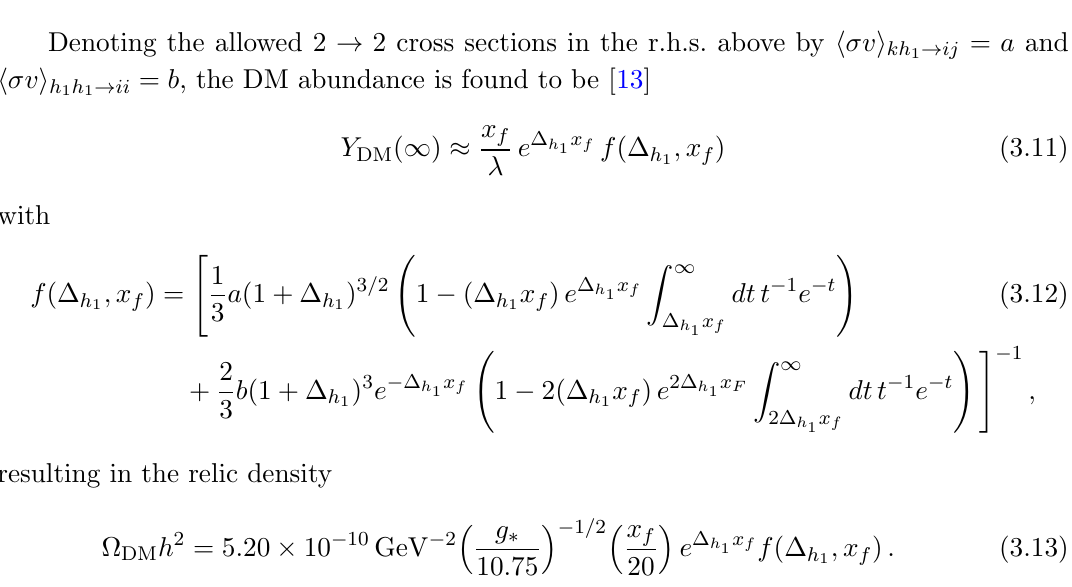
Figure 2 . Dark matter relic density as a function of (cid:1) h channels only ( left ) and both forbidden and SIMP channels ( right ). The measured relic density is shown by the purple curve. We show the results for various illustrative values of coupling and mass: (cid:11) X = 0 : 01 ; 0 : 1 ; 1 and m X = 0 : 1 MeV ; 1